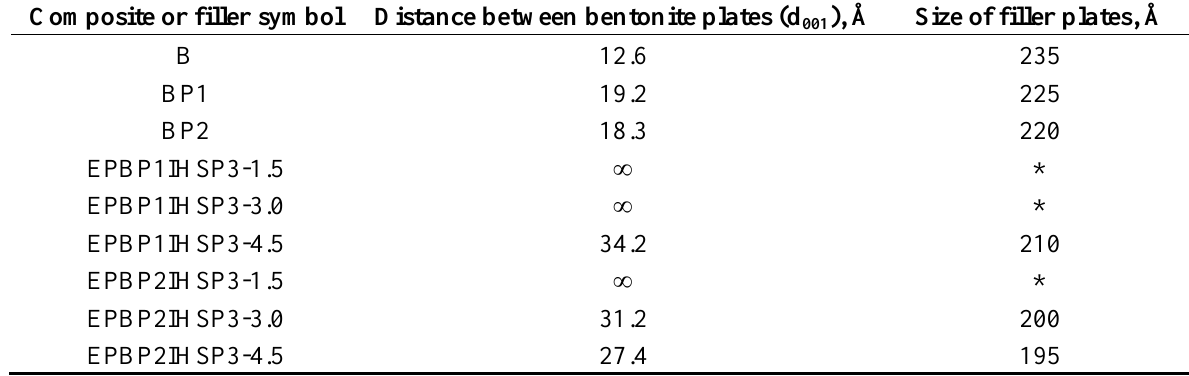
Table 7. Plate sizes and distances between plates for the studied bentonites and